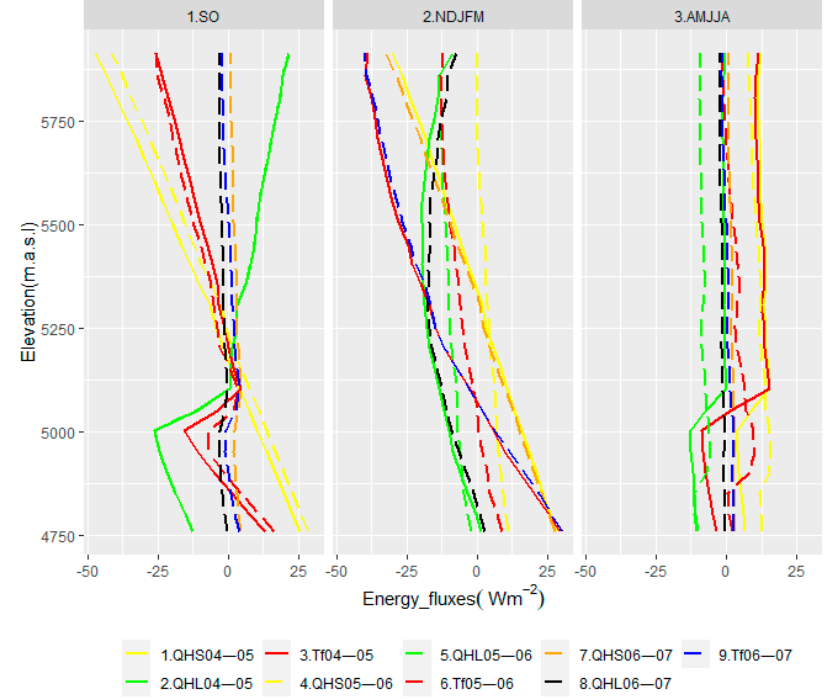
Figure 11. Similar to Figure 9, but for sensible and latent heat, and turbulent